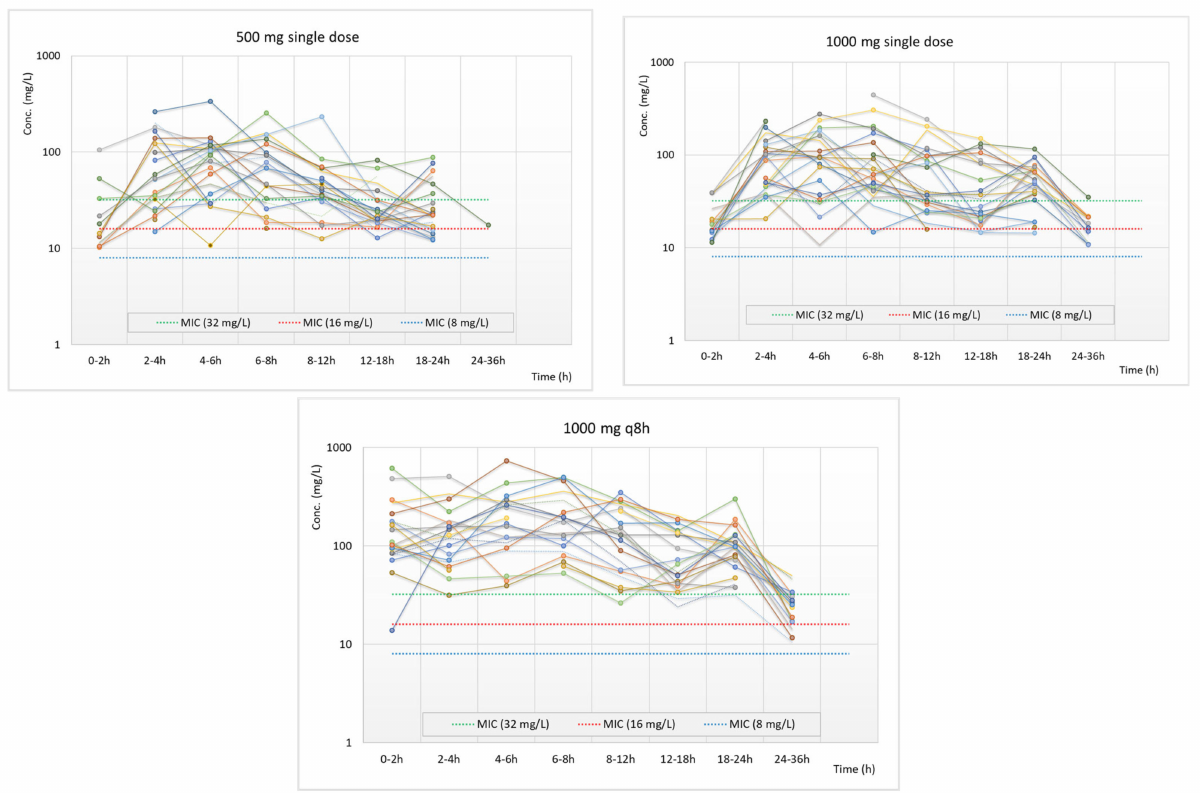
Figure 2. Individual concentrations of fosfomycin in the urine of the subjects (each color represents a different subject) over time in comparison to MIC values of 8, 16, and 32 mg/L (blue, red, and green lines, respectively). For 1000 mg given every 8 h, sampling starts after the administration of the last dose.